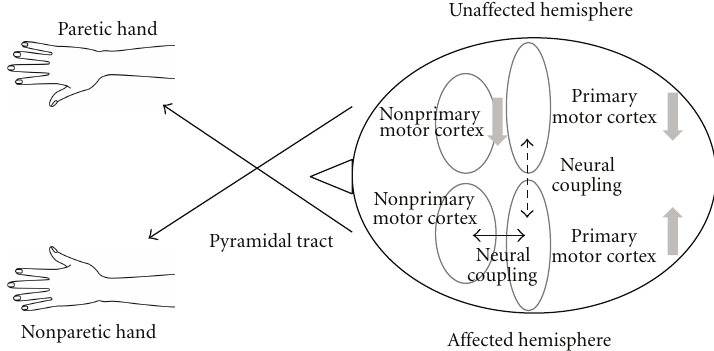
Figure 1: Mechanism of noninvasive brain stimulation therapy in stroke patients. Noninvasive brain stimulation (NIBS) increases ipsilesional primary motor cortex excitability and improves motor function of the paretic side by ameliorating impaired experience- dependent plasticity in stroke patients. NIBS reduces hyperactivity in the primary and nonprimary motor cortices in the una ff ected hemisphere and neural coupling of both hemispheres. Moreover, NIBS enhances neural coupling between the primary and nonprimary motor cortices in the a ff ected hemisphere. In addition to facilitation of the ipsilesional primary motor cortex, excitability modulation in both hemispheres, and reconstructed neural coupling between the primary and nonprimary motor cortices in the a ff ected hemisphere after NIBS contribute to motor recovery in stroke